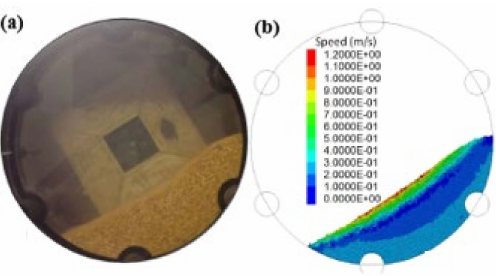
Figure 3. Corn seed particle dynamic angle of repose. ( a ) Test device diagram; ( b ) simulation diagram.